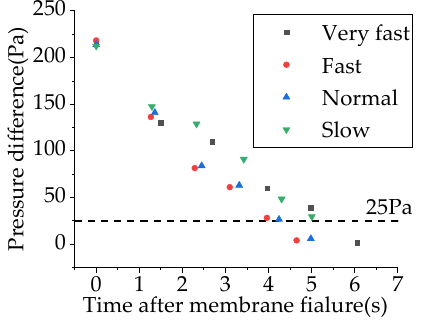
Figure 16. Pressure difference of the air-supported structure in fire event. The pressure after the membrane failure is shown in Figure 17. The pressure decreased to lower than 25 Pa in a few seconds. The time span of the strain relax stage is about 5 s, and there are no remarkable differences between the different fire events.